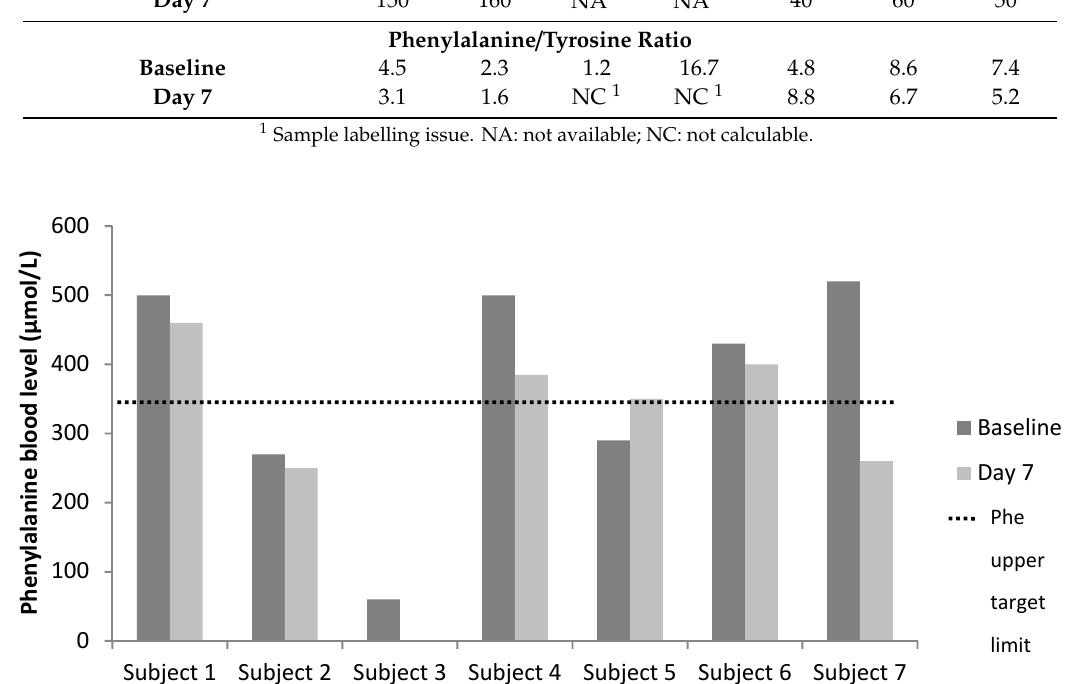
Figure 1. Phenylalanine blood levels of the substudy patient cohort over the study period. Phe target range was 120–360 µ mol / L for patients ≤ 12 years and 120–600 µ mol / L for patients > 12 years. (Note: